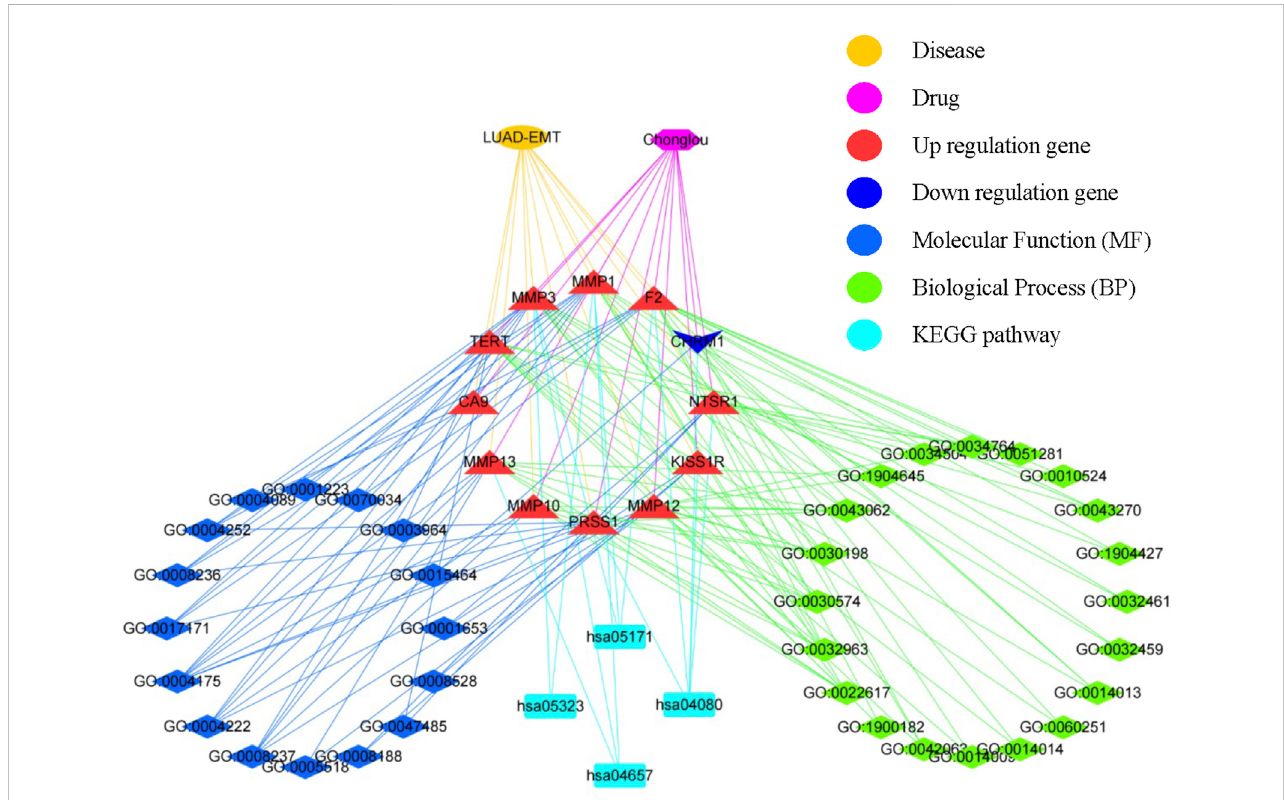
FIGURE 8 Interaction network showing the correlation between disease, drug, core biotargets, molecular function, biological process, and signaling pathways of EMT-LUAD-Chonglou related genes.